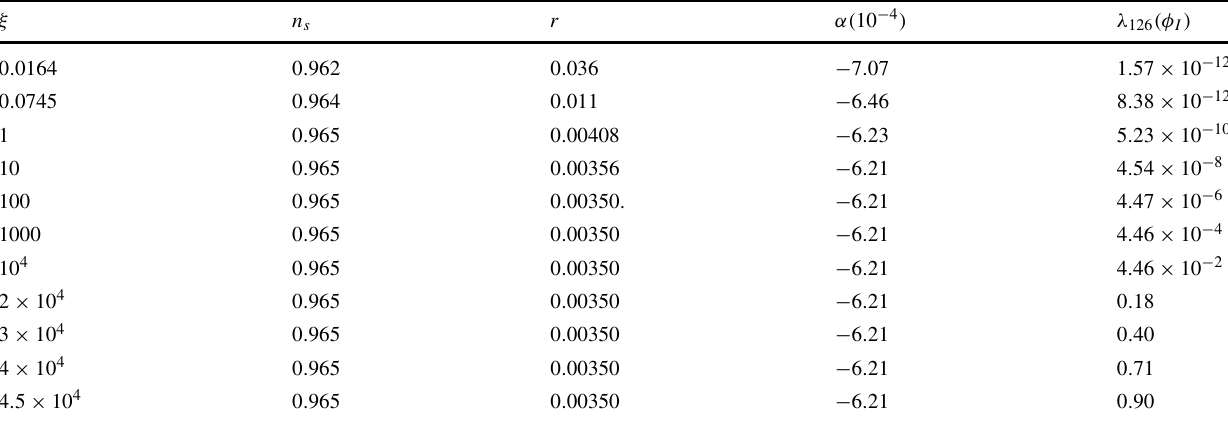
Table 2 Inflationary predictions for various benchmark ξ values and N = 55. Values of ξ < 0 . 0134 ( r > 0 . 036) are excluded by the Bicep/Keck results [78]. In our scenario, λ 126 (φ I ) = O ( 0 . 1 ) is required (see text for